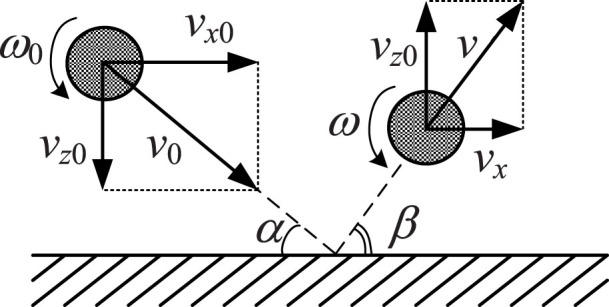
Schematic presentation of an impact.